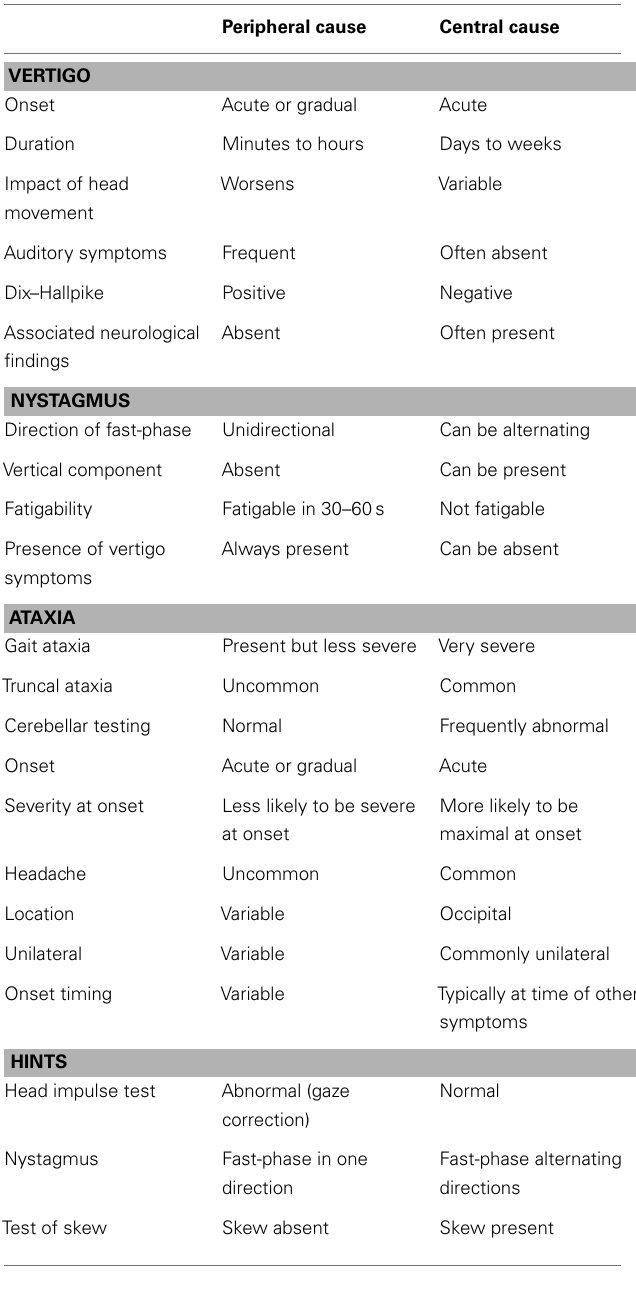
Table 3 | Differentiating features of peripheral and central originated vertigo, nystagmus, ataxia, and